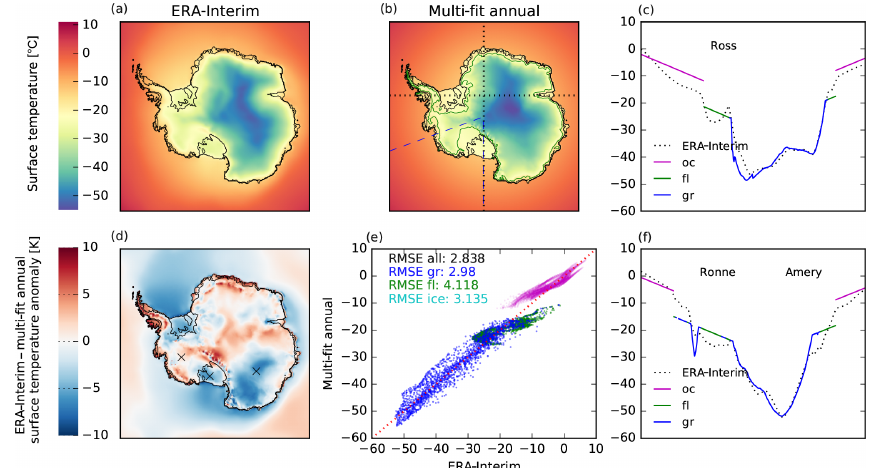
Figure 8. Comparison of ERA-Interim annual mean temperatures (a) with multiple regression fit (b) according to Eq. (9), with 110 ◦ W longitude indicated as blue dashed line, the 1000m surface height isoline in green and the black dotted transects through the large ice shelf regions. Inner parts of the West Antarctic Ice Sheet are less than 1K too cold (d) , while temperatures in the shallow ice shelves of Ross and Ronne–Filchner are overestimated by up to 5K (cf. c and f ). (e) Root-mean-square errors of temperatures in grounded and floating ice sheet regions are 3.0 and 4.1K, respectively.